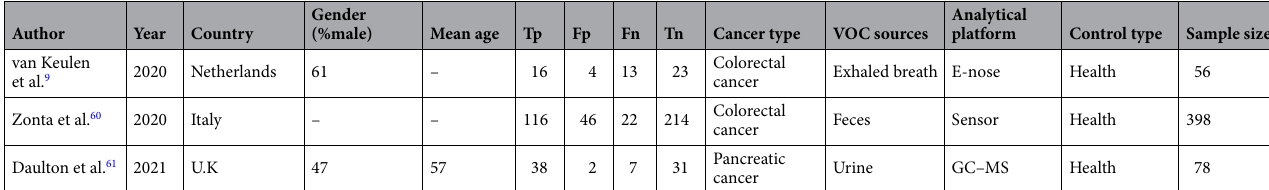
Table 1. Major characteristics of included studies. VOCs volatile organic compounds, GC–MS gas chromatography and mass spectrometry, FAIMS field asymmetric ion mobility spectrometer, SIFT-MS selected